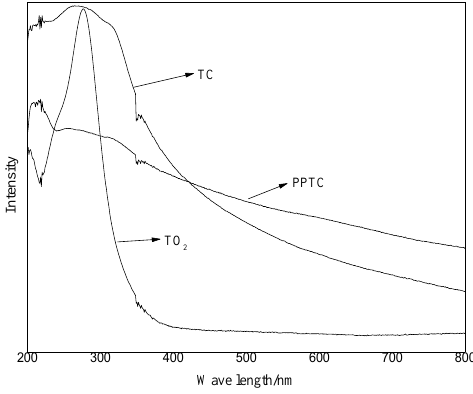
Figure 5. UV-vis absorbance spectra of TiO 2 , TC, and PPTC.